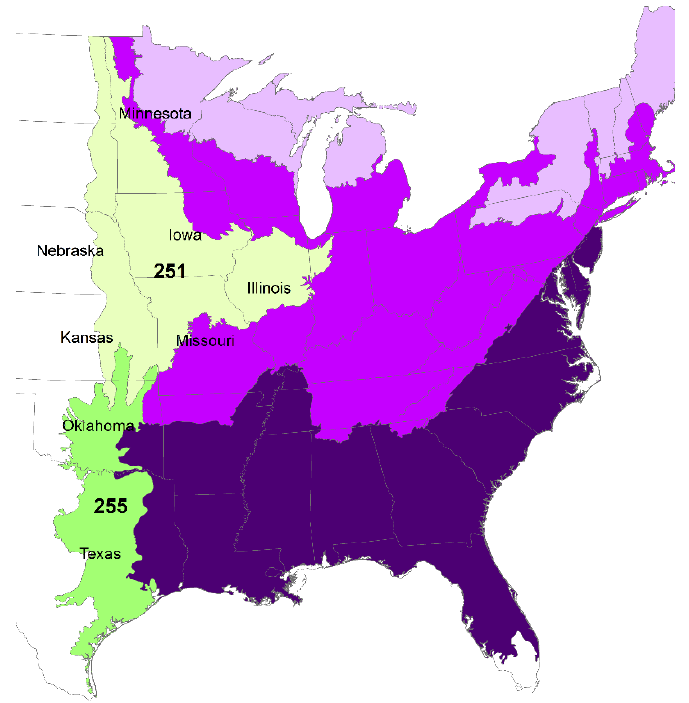
Figure 1. Generalized boundaries of eastern tallgrass prairie grasslands (light green) and forests in the eastern United States (purple colors with variation depicting the southeast region, central east region, and northeast region). The northern (251) and southern (255) prairie ecological provinces are also demarcated.